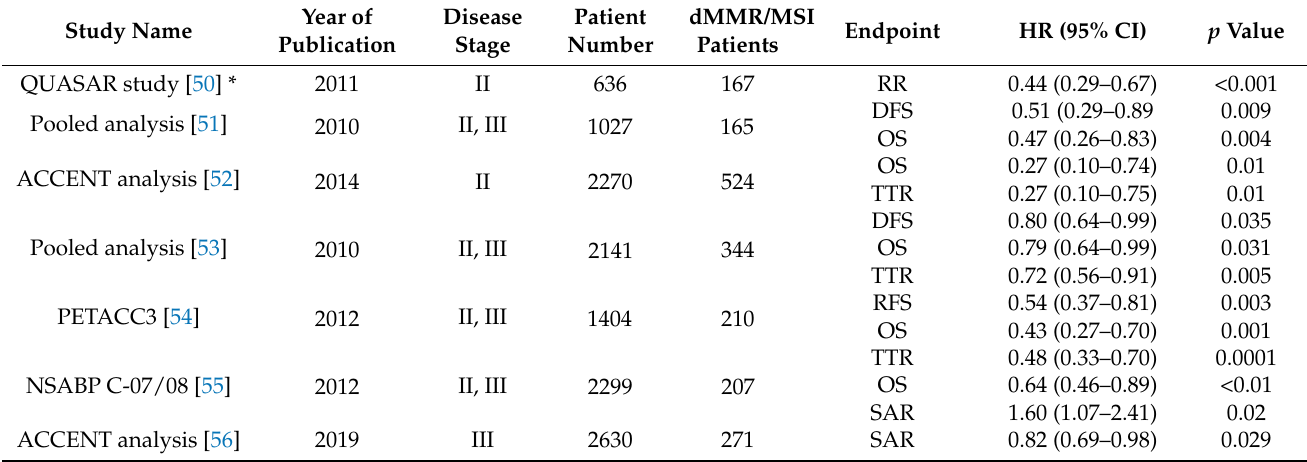
Table 1. Recent studies evaluating the prognostic value of dMMR/MSI in colorectal